Question: Generate an informative caption for the figure above.
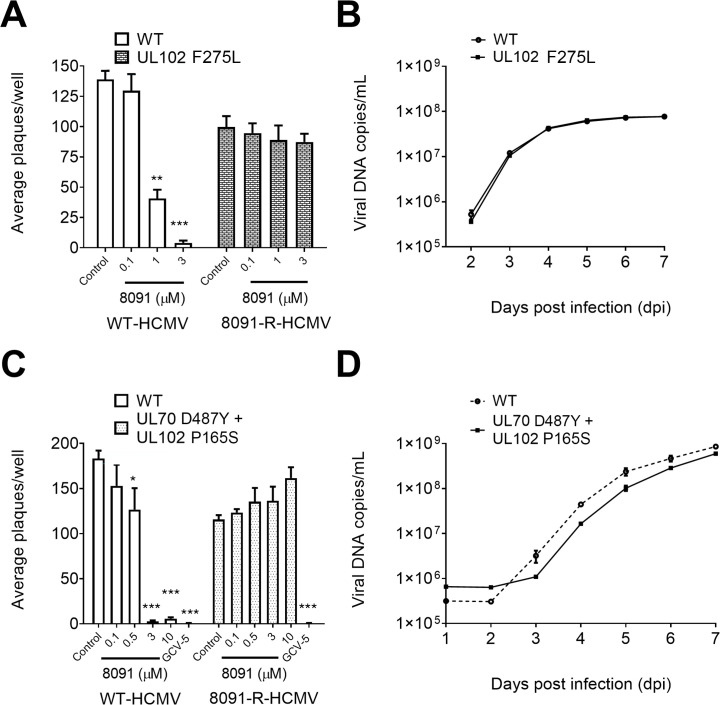
Answer: HCMV Towne carrying UL102 F275L or UL70 D487Y, together with UL102 P165S, is resistant to MLS8091. ( A ) HFFs were infected with 200 PFUs/well of WT or UL102 F275L (MS-8091-R1) HCMV Towne and treated with the indicated concentrations of MLS8091. Plaques were stained and counted at day 10 post-infection. ( B ) HFFs were infected with WT or UL102 (F275L, MS-8091-R1) HCMV Towne (MOI 0.1), supernatants were collected from day 1 to day 7 post-infection, and viral DNA load was quantified by US17 real-time PCR. ( C ) HFFs were infected with 200 PFUs/well of WT or UL102 P165S + UL70 D487Y HCMV Towne (SS-8091-R-1) and treated with the indicated concentrations of MLS8091. Plaques were stained and counted at day 10 post-infection. ( D ) HFFs were infected with WT or UL102 P165S + UL70 D487Y HCMV Towne SS-8091-R-1 (MOI 0.1), supernatants were collected at days 1–7 post-infection, and viral DNA load was quantified by US17 real-time PCR. Statistical significance is compared to infection only (control).